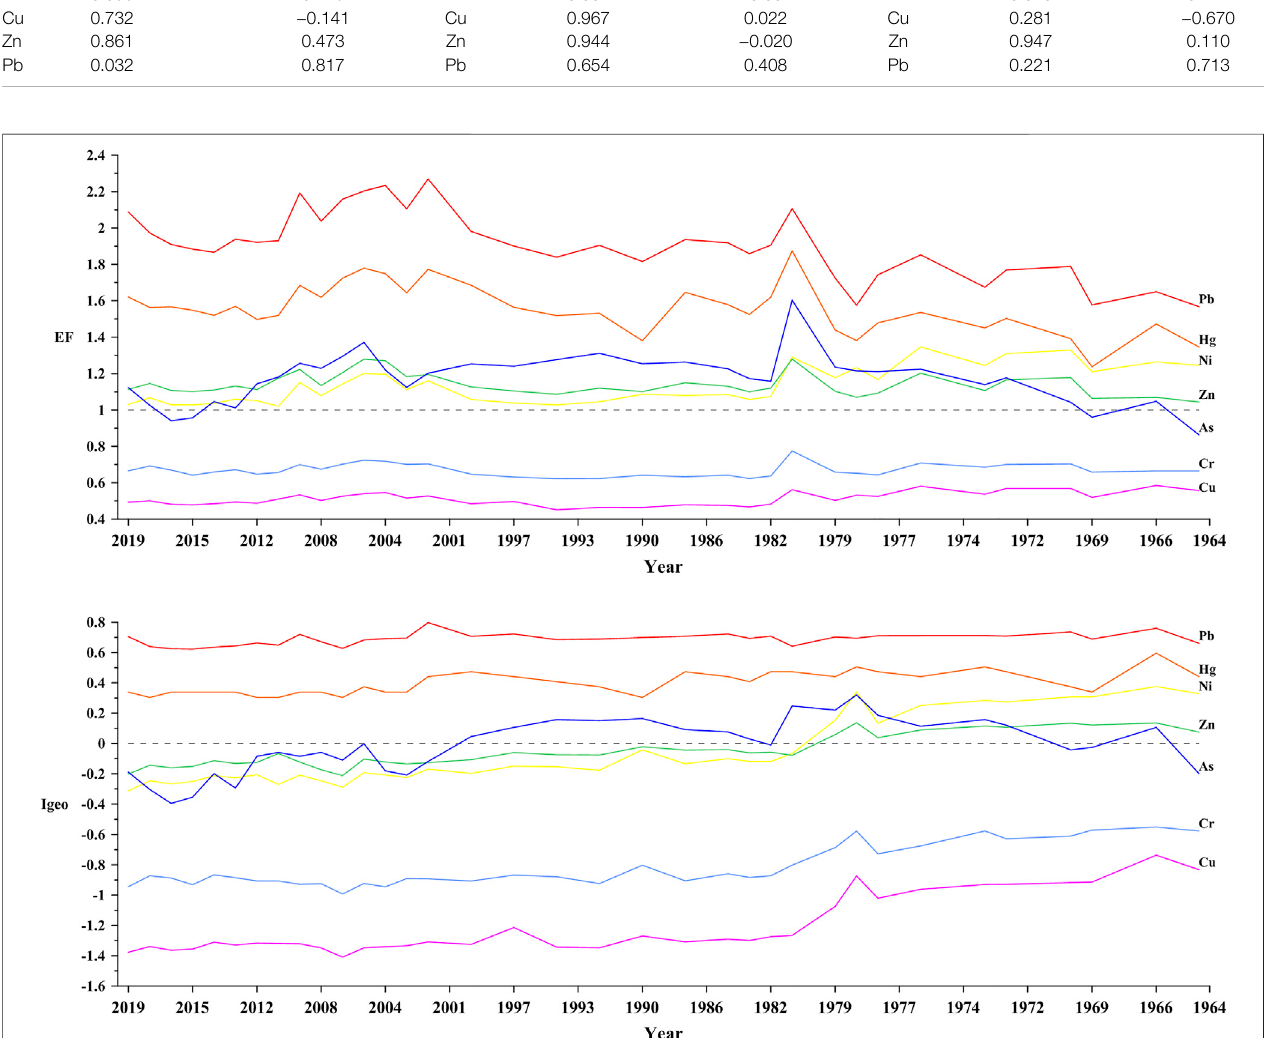
FIGURE 7 | Enrichment factor (EF) and index of geo-accumulation (Igeo) of trace metals in sediment core SKL8-2 of Songkhla Lake.